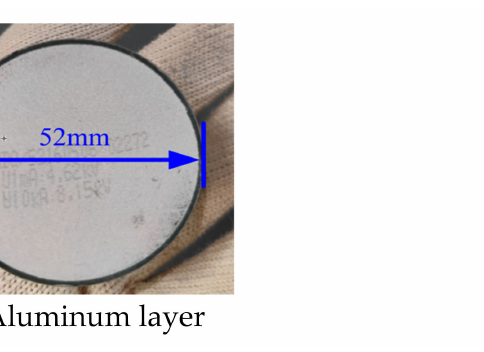
Figure 4. Typical appearance of a normal arrester